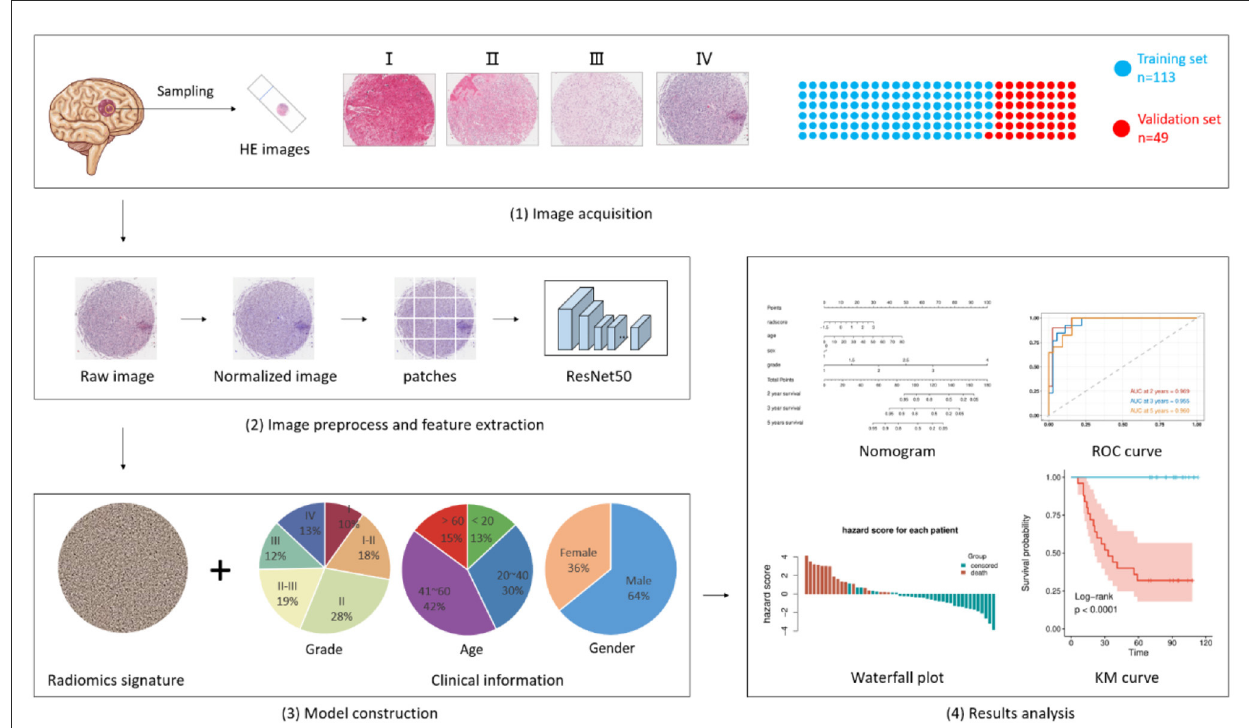
FIGURE1 Flowchart of pathomics and clinical-pathomics model construction. i. Biopsy samples acquired from 162 patients were scanned and uploaded to form a training set ( n = 113) and a validation set ( n = 49). ii. Digital images were segmented into patches and inputted into pre-trained ResNet50 for feature extraction. An integrative pathomics signature was generated in this process. iii. The pathomics signature along with several clinical characteristics was fed into another model for model construction. iv. results were collected and analyzed. The Kaplan-Meier curve was used to estimate DFS and OS. The time-dependent receiver operating characteristic (ROC) curves, along with nomograms, were used to assess the diagnostic performance.